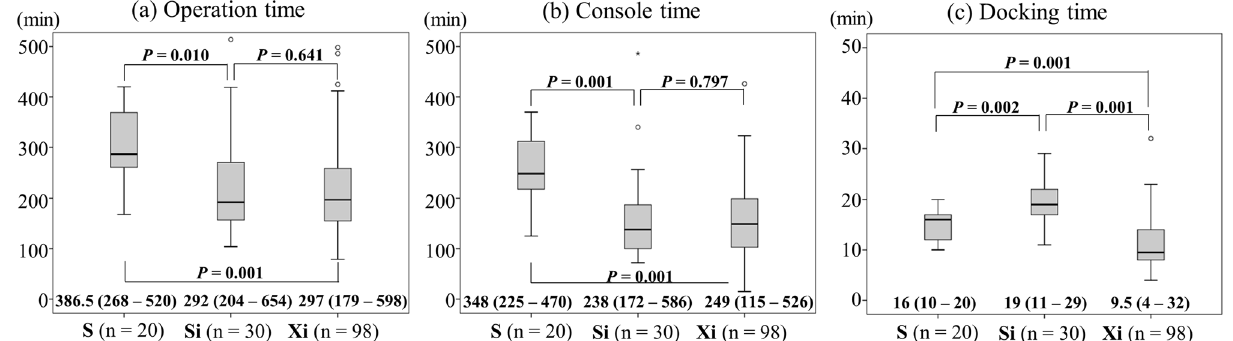
Figure 1. ( a ) Operation time, ( b ) console time and ( c ) docking time. Quantitative results are expressed as medians and ranges. The bars in the figure are expressed as means ± SD. P values were calculated with Mann– Whitney U test. S, da Vinci S; Si, da Vinci Si; Xi, da Vinci